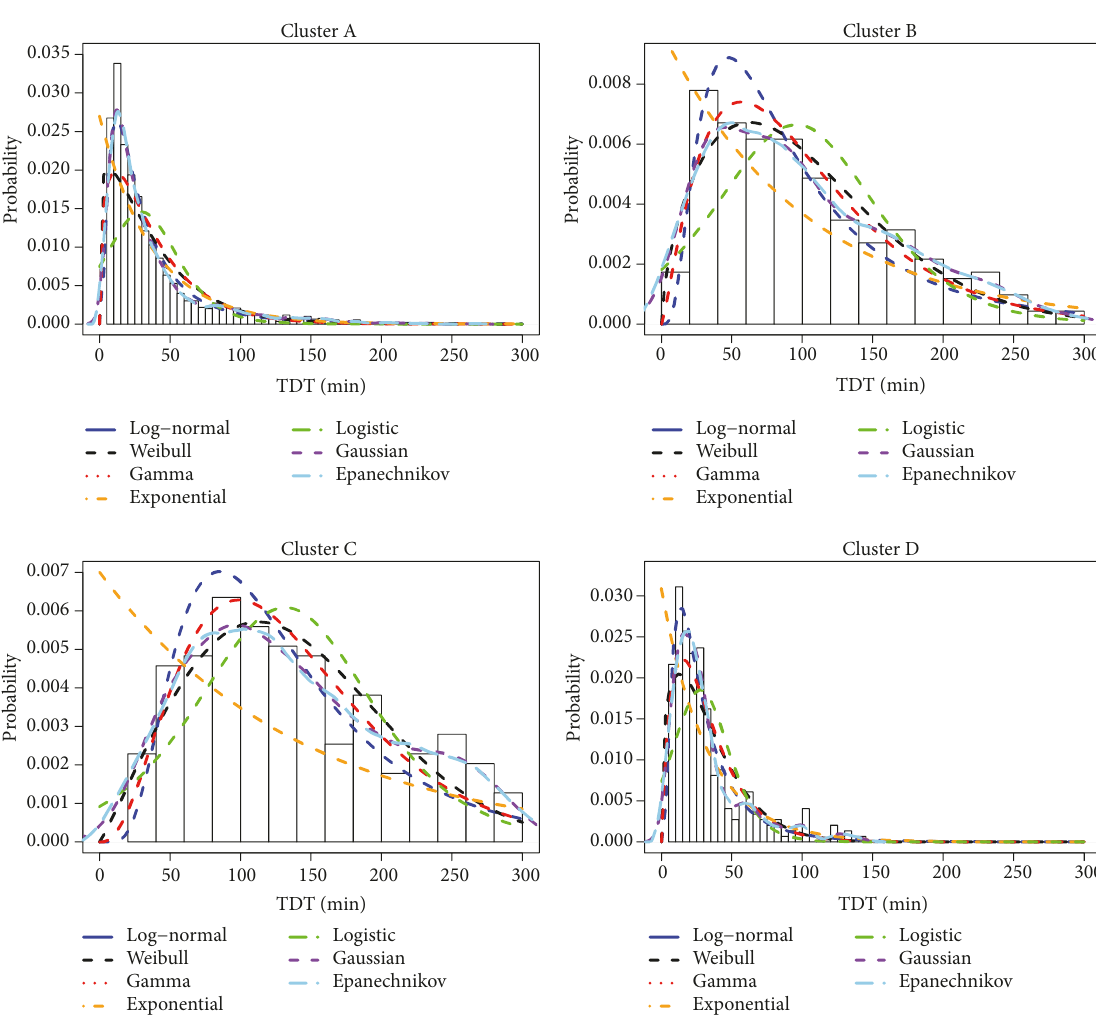
Figure 8: Fitting results of